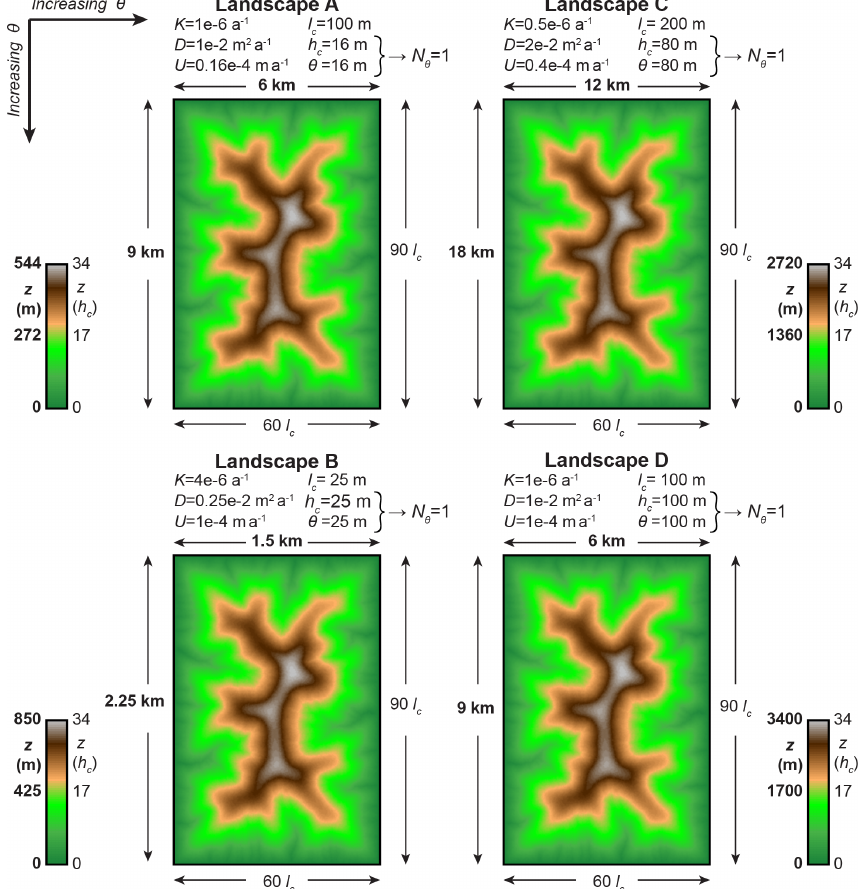
Figure 2. Horizontal and vertical geometric similarity of landscapes with equal incision-threshold numbers N θ . Elevation maps show that the four landscapes of Fig. 1 are geometrically similar in the vertical direction as well. We show domain sizes and color-scale elevations both in kilometers or meters (top and left, bold fonts) and in units of characteristic length and height l c and h c (bottom and right, normal fonts). Note that we use color scales that are normalized by h c , i.e., each color corresponds to the same elevation in units of h c across all four landscapes. Therefore, the fact that the four maps have the same color pattern shows that their elevations are equivalent when normalized by h c , i.e., the landscapes are geometrically